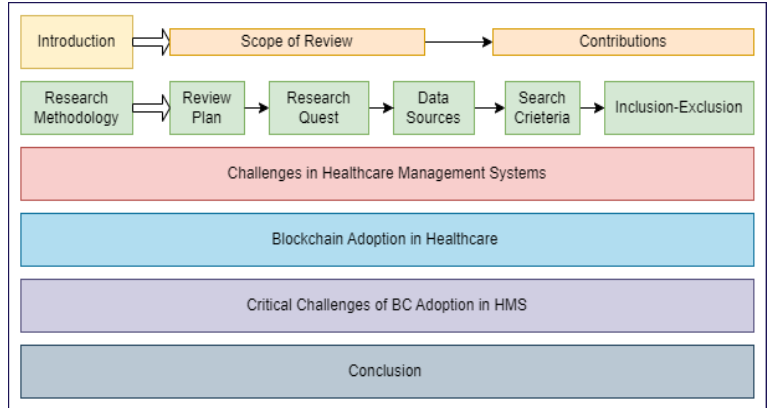
Figure 1. Structure of the